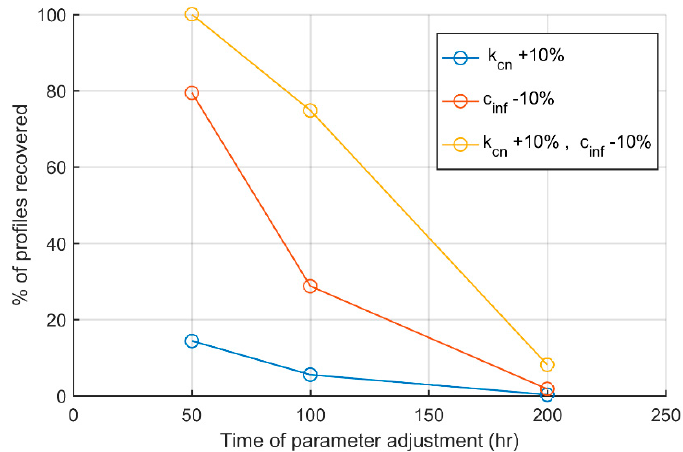
Figure 7. Percent of profiles recovered as a function of the time when parameter adjustment was performed. Blue line indicates k cn increase by 10%, red line indicates c inf decrease by 10% and yellow a simultaneous increase of k cn and decrease of c inf by 10% for different times during the inflammatory